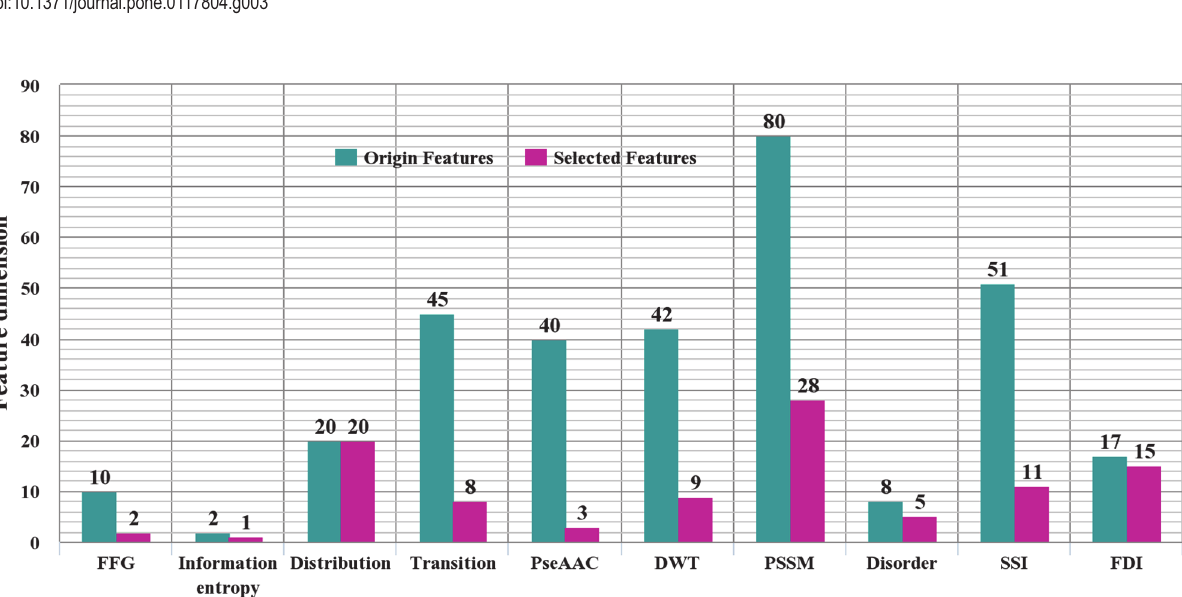
Fig 3. The numbers of each kind of features in the original and optimal feature set. The four kinds of features are based on sequence composition, physicochemical properties, evolutionary information, and structural information, respectively.